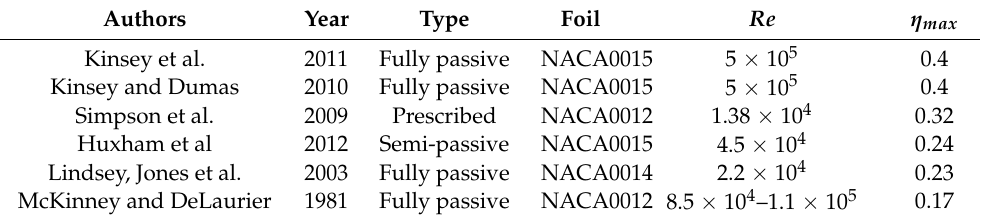
Table A2. Experimental studies.